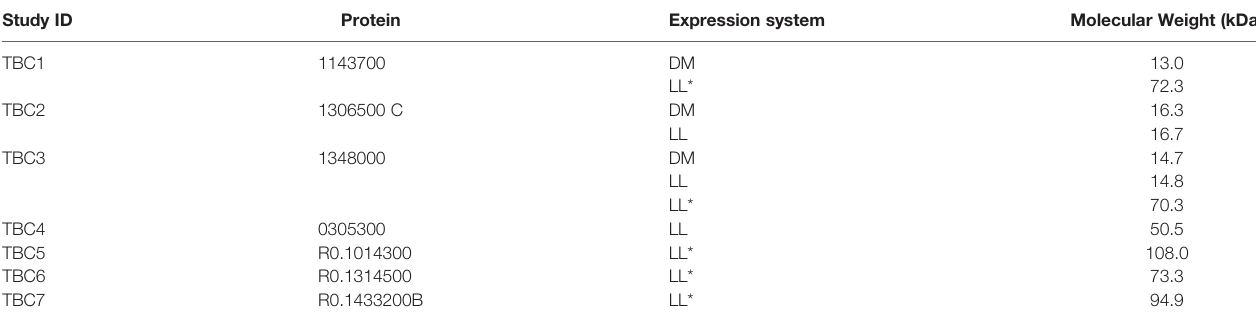
TABLE 2 | Recombinant proteins used in mouse immunization